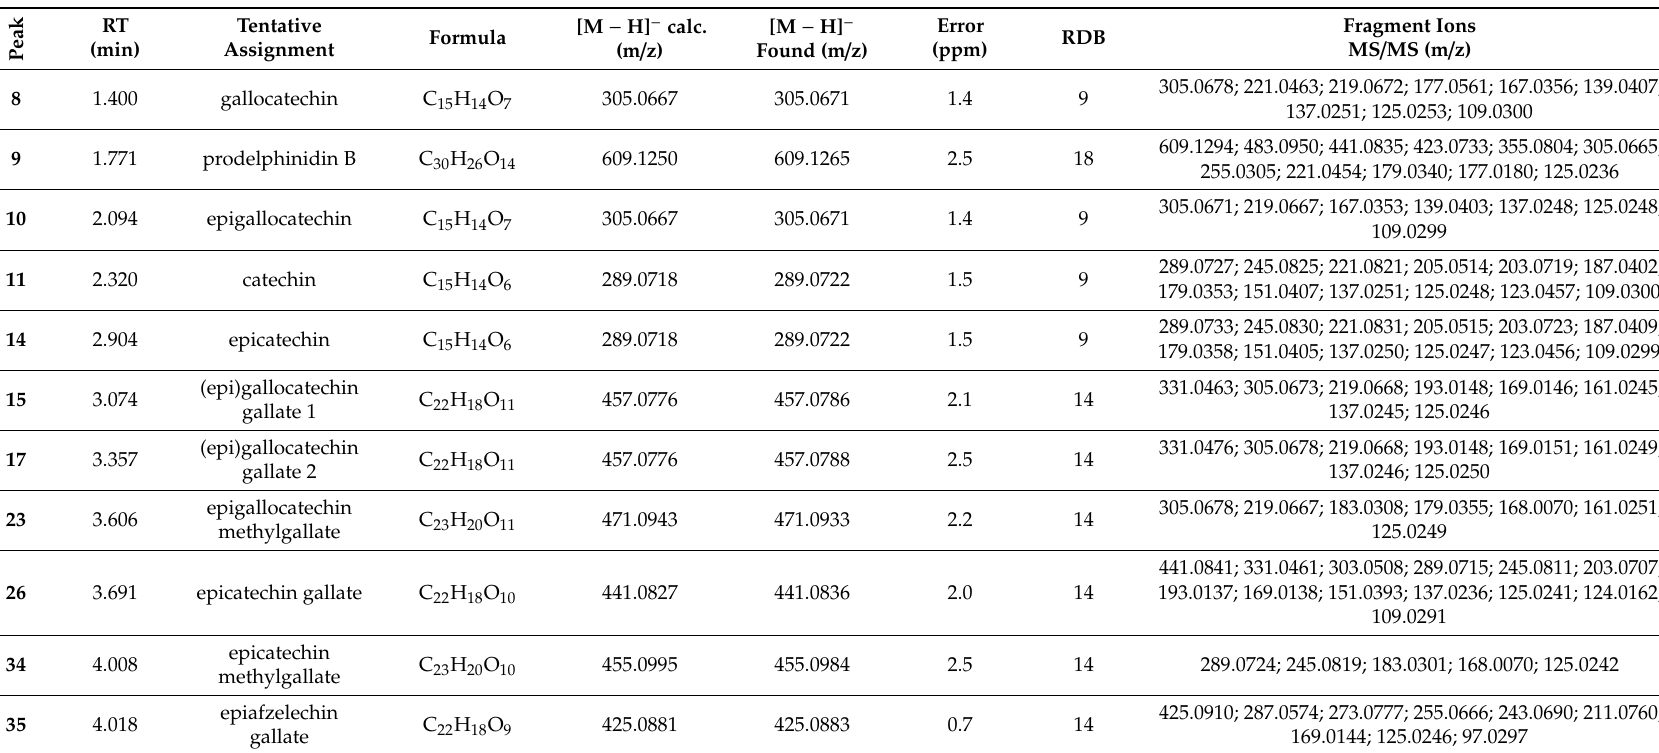
Table 2. TOF-MS and TOF-MS / MS of tentatively identified flavanols in investigated green tea extracts. Compounds are numbered based on their RT in the whole total ion current chromatogram. RT = Retention Time; RDB = Ring Double Bond equivalent